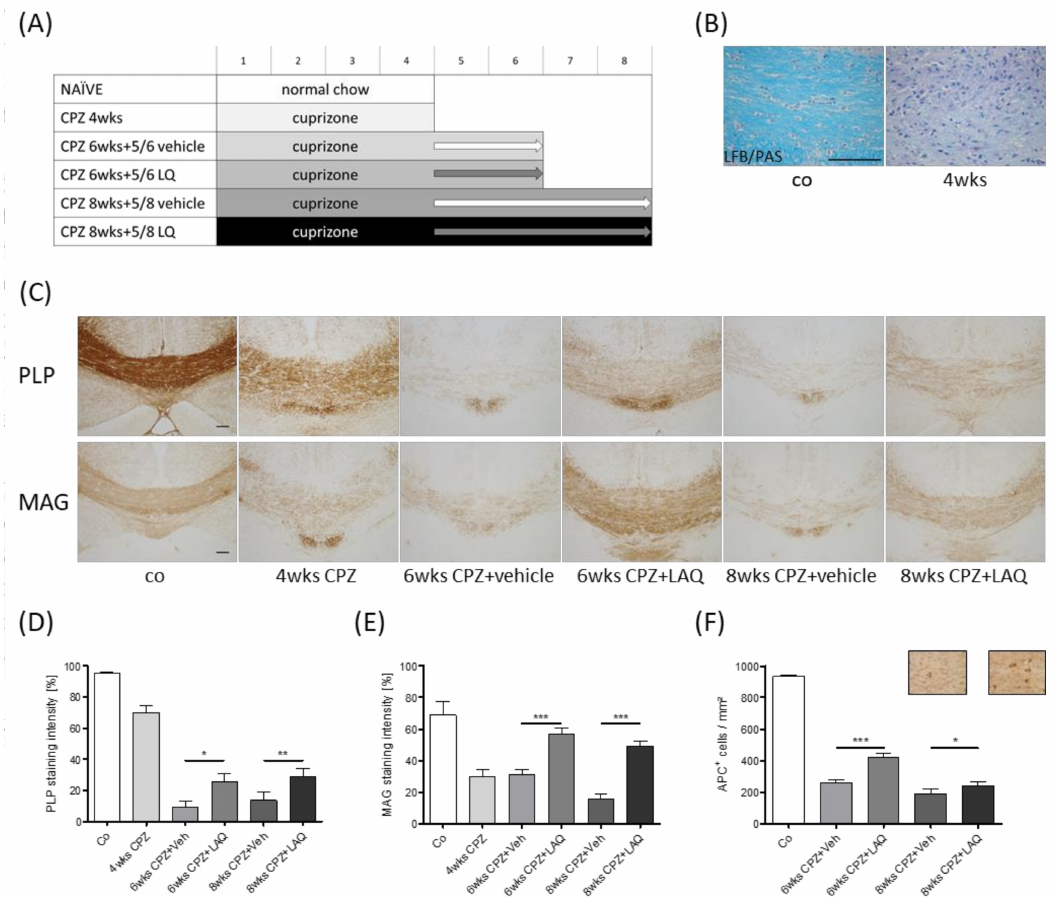
Figure 1. Influence of laquinimod on remyelination in the non-supportive environment. ( A ) Schematic depiction of the experimental setup. Numbers indicate the duration of the experiment in weeks. The control group is colored in white, cuprizone (CPZ) intoxication groups are colored in grayscale and black. The arrows indicate treatment with either the vehicle (Veh, light gray) or laquinimod (LAQ, dark gray) solutions. ( B ) Representative image of Luxol fast blue / periodic acid–Schi ff (LFB / PAS) staining of a control animal and an animal intoxicated with cuprizone for 4 weeks. ( C ) Representative images of anti-PLP and anti-MAG stained sections of the midline corpus callosum. Densitometric analysis of ( D ) anti-PLP and ( E ) anti-MAG staining intensity (repetitive Mann–Whitney test, as indicated). ( F ) Quantification of APC + cell numbers (repetitive Mann Whitney test as indicated). Representative images of anti-APC immunohistochemical stained sections of the medial corpus callosum of 8 weeks cuprizone plus vehicle (left) or laquinimod (right) treatment groups. Scale bar: 100 µ m. The following symbols were used to indicate the level of significance: * p < 0.05, ** p < 0.005, and *** p <